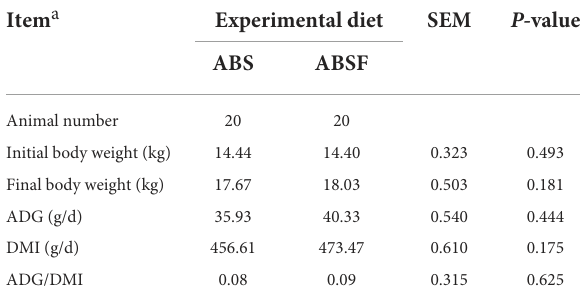
TABLE 2 Growth performance of goats fed a total mixed ration supplemented with anthocyanin-rich black cane silage (ABS) or